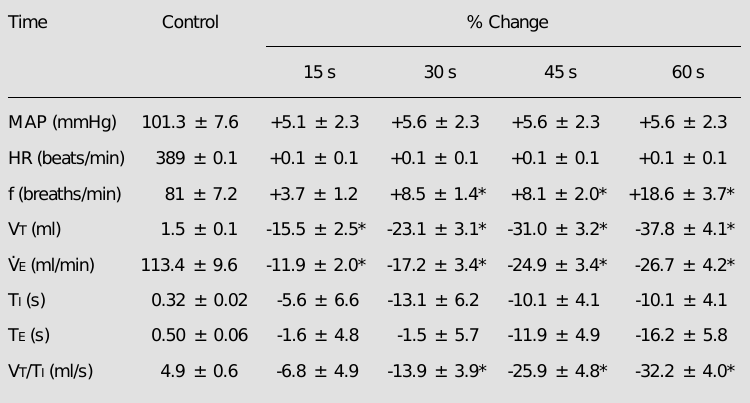
Figure 1 - The diagram repre- sents the ventral medullary sur- face of the rat summarizing re- sults obtained from 74 microin- jections in 25 animals. Filled circles indicate sites where uni- lateral microinjections of kynu- renic acid produced decreases in ventilation, tidal volume and inspiratory drive concurrently with tachypnea, whereas the small open dots indicate sites where no significant respiratory changes were obtained. For clarity all microinjections are represented on the left side re- gardless of the actual side of application. C 1 = First cervical nerve, VI and XII = 6th and 12th cranial nerve rootlets, respec- tively.